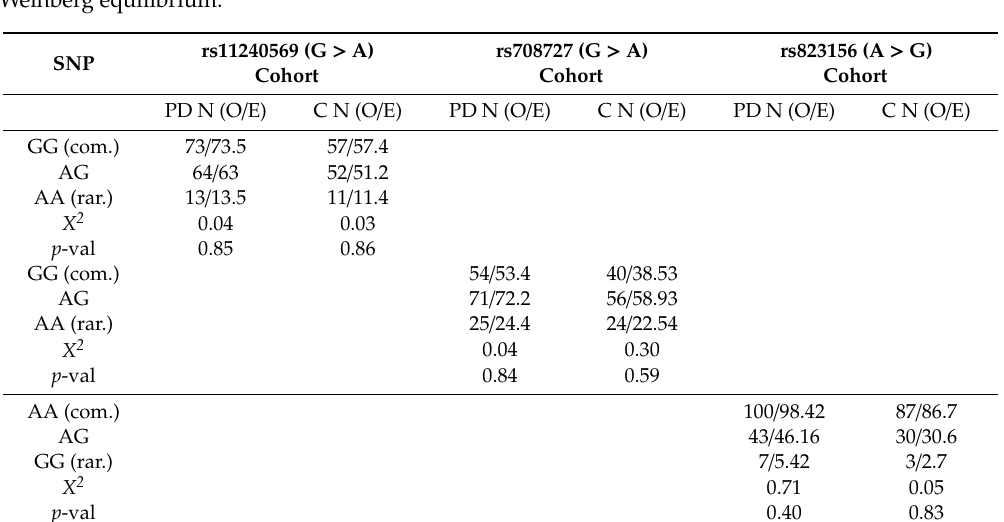
Table 2. Genotype distribution of all tested A1 SNPs in PD and control cohorts conforms to Hardy- Weinberg